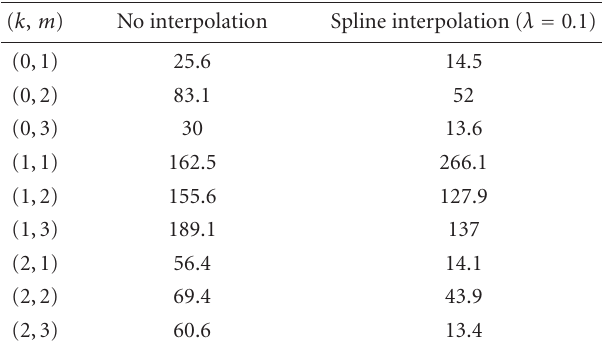
Table 1: Position error (nm) with parameters ( k , m